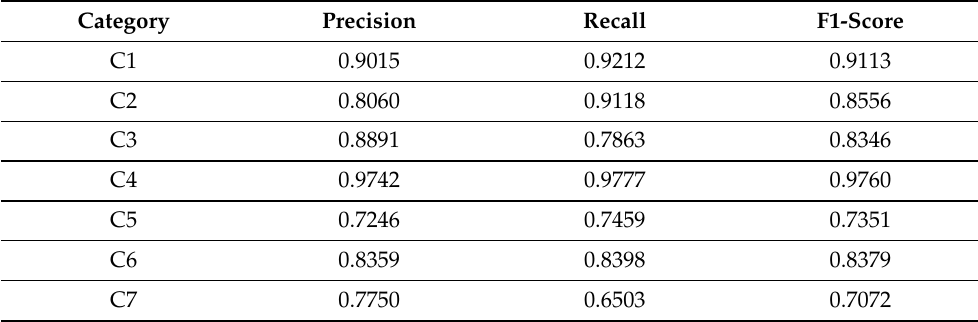
Table 2. Performance evaluation of categories in the GCD dataset with the proposed CSSL